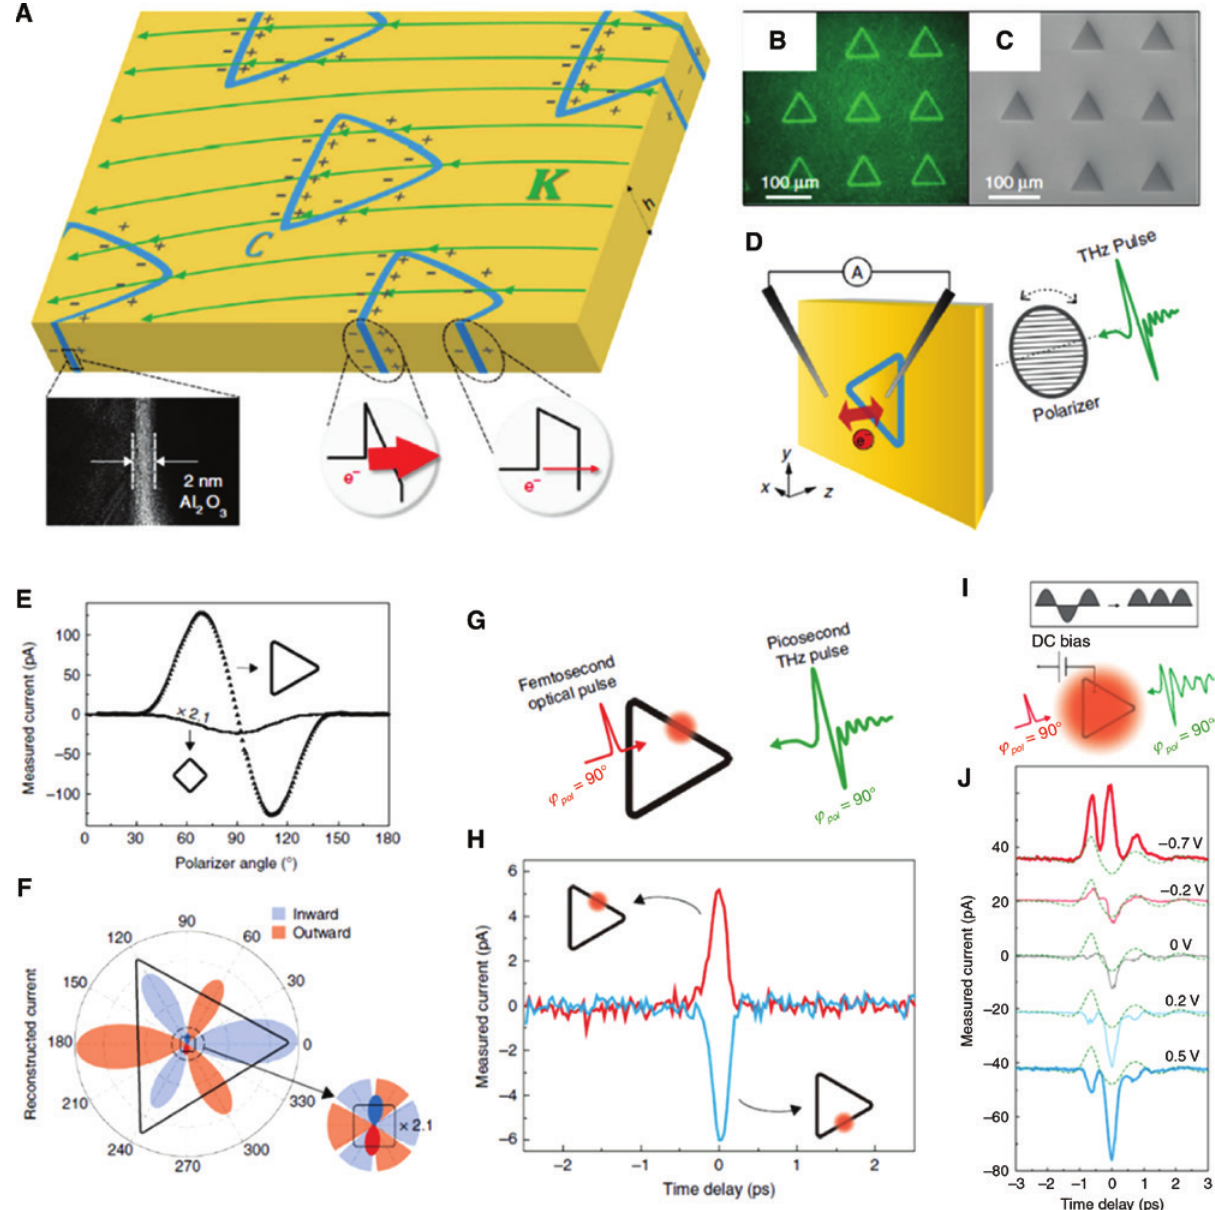
Figure 13: Terahertz tunneling rectification in metal nanogaps. (A) Terahertz-pulse–driven tunneling current rectification using a ring-shaped nanogap sample fabricated in a metallic film. Incident terahertz field induces surface current on a metallic film (denoted by a vector field K ), which applies terahertz electric potential across the ring-shaped tunneling barriers (denoted by contour C ). The shape of the ring is critical for the terahertz tunneling rectification, which affects directly to the accumulation of finite electrons inside the metallic island under a terahertz pulse excitation. A TEM picture shows the cross- sectional image of the barrier, which is composed of 2-nm-thick Al O layer sandwiched in the gold film. (B) An optical microscope image 2 3 and (C) SEM image of the sample. (D) Experimental scheme. The incident THz field is linearly polarized and induces eddy current on the gold surface, which acts as a current source K both inside and outside the triangle as shown in (A). (E) Measured tunneling current as a function of incident terahertz polarization. Triangle- and rectangle-shaped barriers are exploited, which possess different symmetry properties. (F) Polar plots of the data (E). (G) Ultrafast tunneling current measurement scheme using femtosecond optical pulse illumination on the ring-shaped barriers. (H) Depending on the excitation position and time delay between the terahertz and optical pulses, the optical pulse generates position-sensitive and time-dependent switching signal. (I) Schematic of THz full-wave rectification. A DC bias imposes potential difference for the whole ring, thereby giving a preferred current direction. The optical spot is expanded to probe the total tunneling current flowing through the whole ring. (J) Measured terahertz full-wave rectification. Dashed green curves show the terahertz potential profile. The value of the applied DC bias is denoted for each curve, and the curves are vertically displaced for clarity. The figures are reproduced from Reference